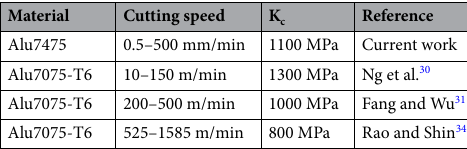
The increase of the cutting energy at low h (also referred to as size effect in the cutting energy), though being noted, has not obtained a unanimous explanation. While e.g. Woon and Rahman 27 have argued that this effect has purely geometric nature, i.e. is solely determined by the ratio between tool radius and h, Weber et al. 35 have suggested that a material hardening should be a reason for variation of cutting energy with size. In this case, the size effect due to strain hardening has been related to much higher strain gradients and thus to higher disloca- tion densities at small tool radii. Fang et al. 36 have also suggested an extreme case of nanocutting at the feeds smaller than inter dislocation distance (tens of nanometres), when the hardening is caused by the starvation of strain carriers. We will not consider this last mechanism as this scale is far beyond the reach of the proposed microcutting setup. In the following, utilizing the force measurements from both micro- and macroscale cutting experiments, we will try to discriminate the factors determining size dependence of the specific cutting energy. Figure 6 plots the values of K c calculated from the force measurements on Fig. 5 in log–log scale. Two features are immediately evident from this plot. First, the data can be well fitted by power laws, however, the exponent (slope of the lines) is different for feeds below 10 µm and above 50 µm. Such a change in the power law exponent is typically related to a fundamental alteration of a material property or to a change in the mechanism of the process (e.g. change of the plastic deformation mechanism in strain/stress curves). So, it can be concluded that at high and low feeds the processes determining the specific cutting energy are different. For very high feeds the